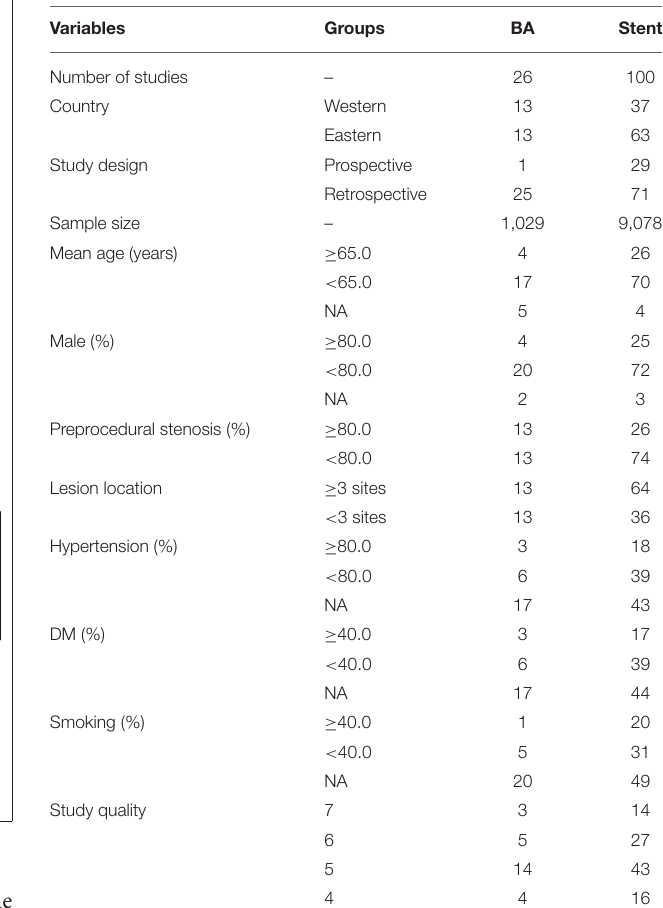
TABLE 1 | Summary of characteristics of identified individuals.